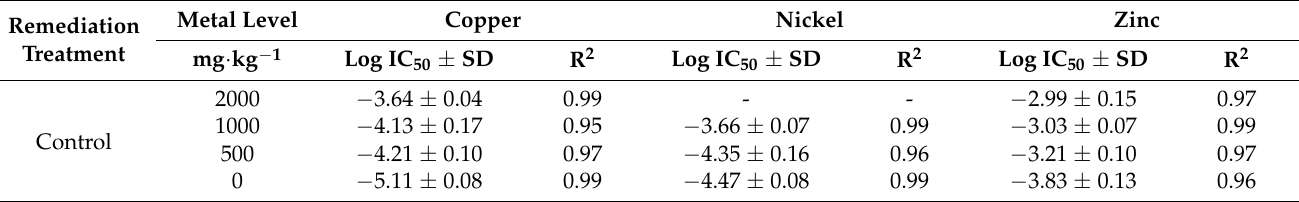
Figure 3. Dose–response curves of relative bacterial growth versus added Zn to bacterial suspensions from a polluted soil with four Zn levels: 0 ( A ), 500 ( B ), 1000 ( C ), and 2000 ( D ) mg Zn·kg − 1 . Each Zn level was remediated with four treatments: crushed mussel shell amendment (CMS, blue dots and line), pine bark amendment (PB, green dots and line), EDTA washing (black dots and line), and control (red dots and line). Table 1. Bacterial community tolerance to Cu, Ni, and Zn in a polluted soil with four metal levels (0, 500, 1000, and 2000 mg · kg − 1 ). Each metal level was remediated with four remediation treat- ments: crushed mussel shell amendment (CMS), pine bark amendment (PB), EDTA, and control (no